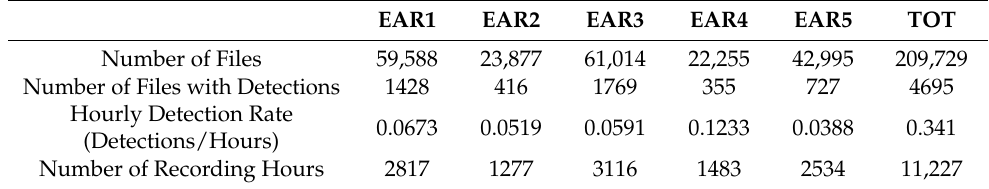
Table 3. Summary of the data collection: number of files and hours of recording in the five